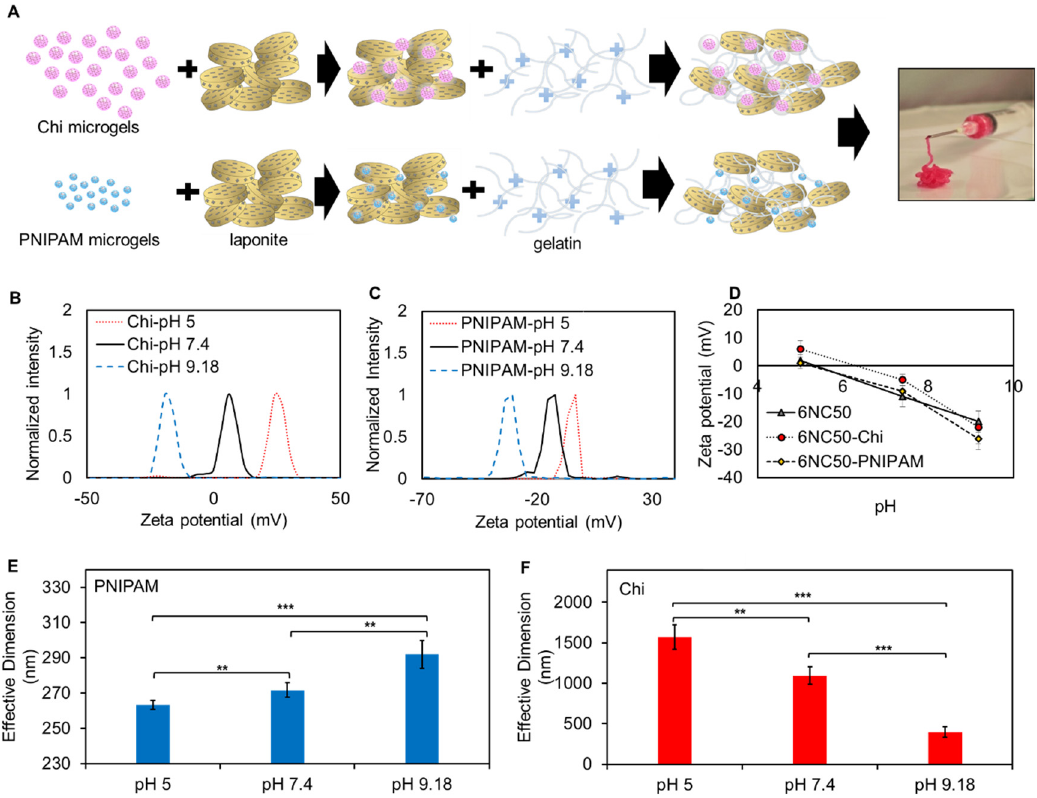
Figure 1. Electrostatic interactions between gelatin and laponite resulted in formation of pH responsive nanocomposite. ( A ) schematic of fabrication of shear-thinning gel containing pH responsive microgels ( B ) zeta potential of Chi particles at different pH; ( C ) zeta potential of PNIPAM- co -Acrylic acid (PNIPAM) particles at different pH; ( D ) zeta potential of 6NC50 and 6NC50 loaded with Chi and PNIPAM particles at different pH; ( E ) effective diameter of PNIPAM particles at different pH; ( F ) effective hydrodynamic dimension of Chi particles at different pH.